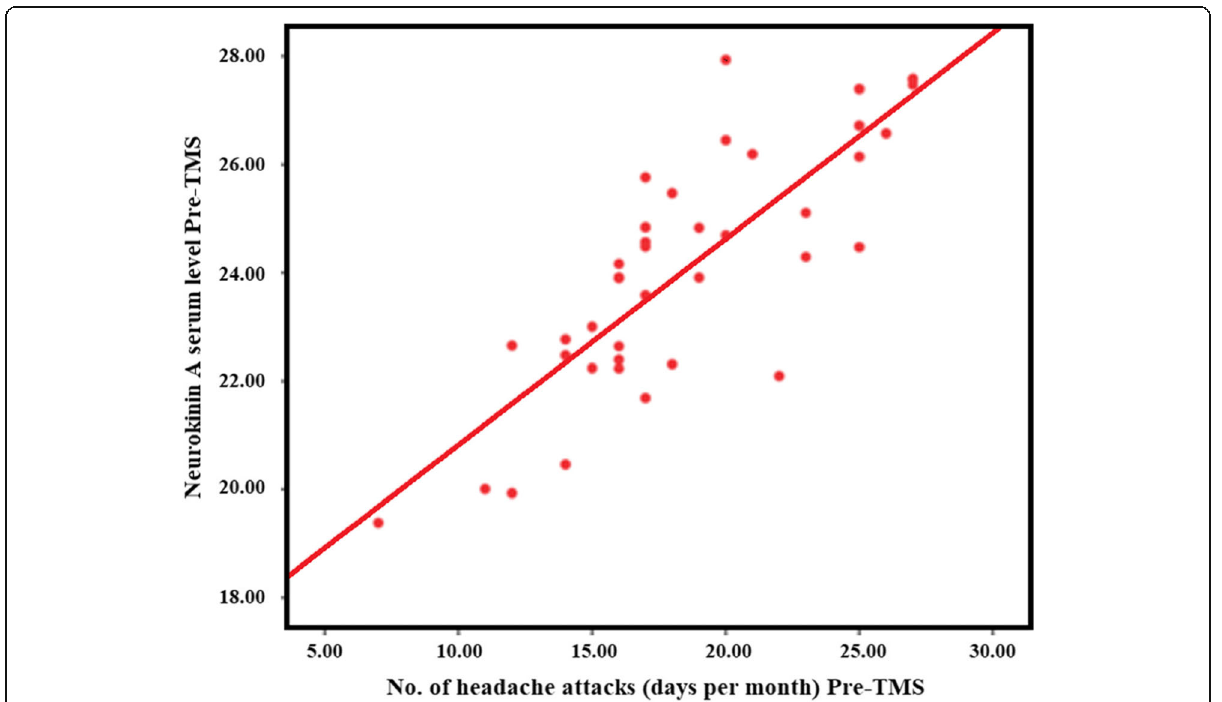
Fig. 1 Correlation between neurokinin A serum level and number of headache attacks pre-TMS